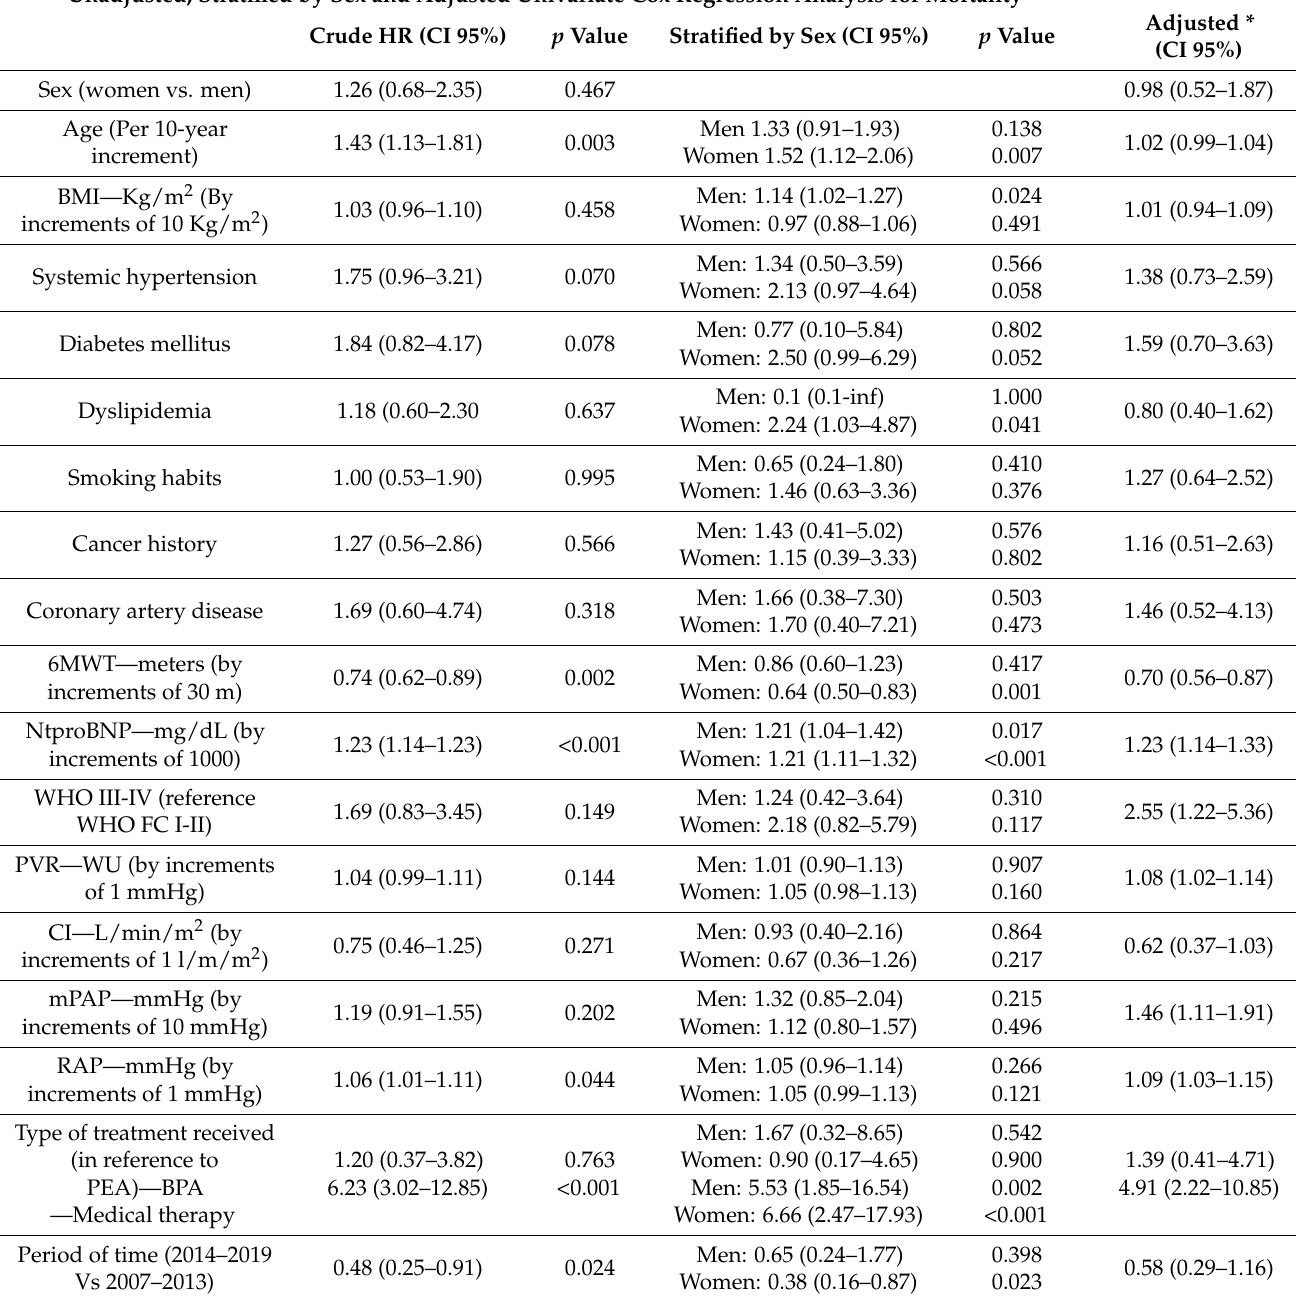
Table 2. Mortality Cox regression